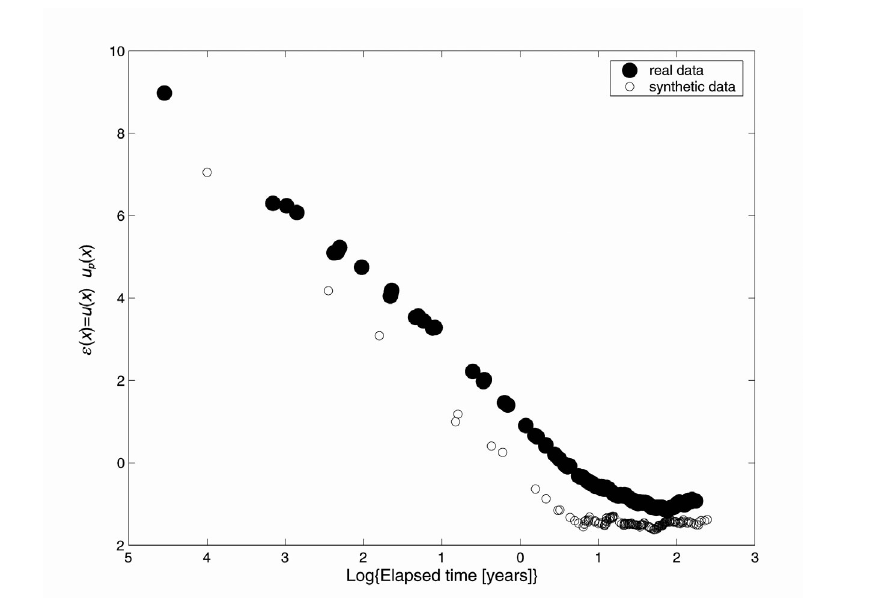
Fig. 1. Plot of the residuals ε ( x ) (see equation 23 in Faenza et al. , 2003) for real and synthetic catalogs as a function of the time elapsed since the most recent